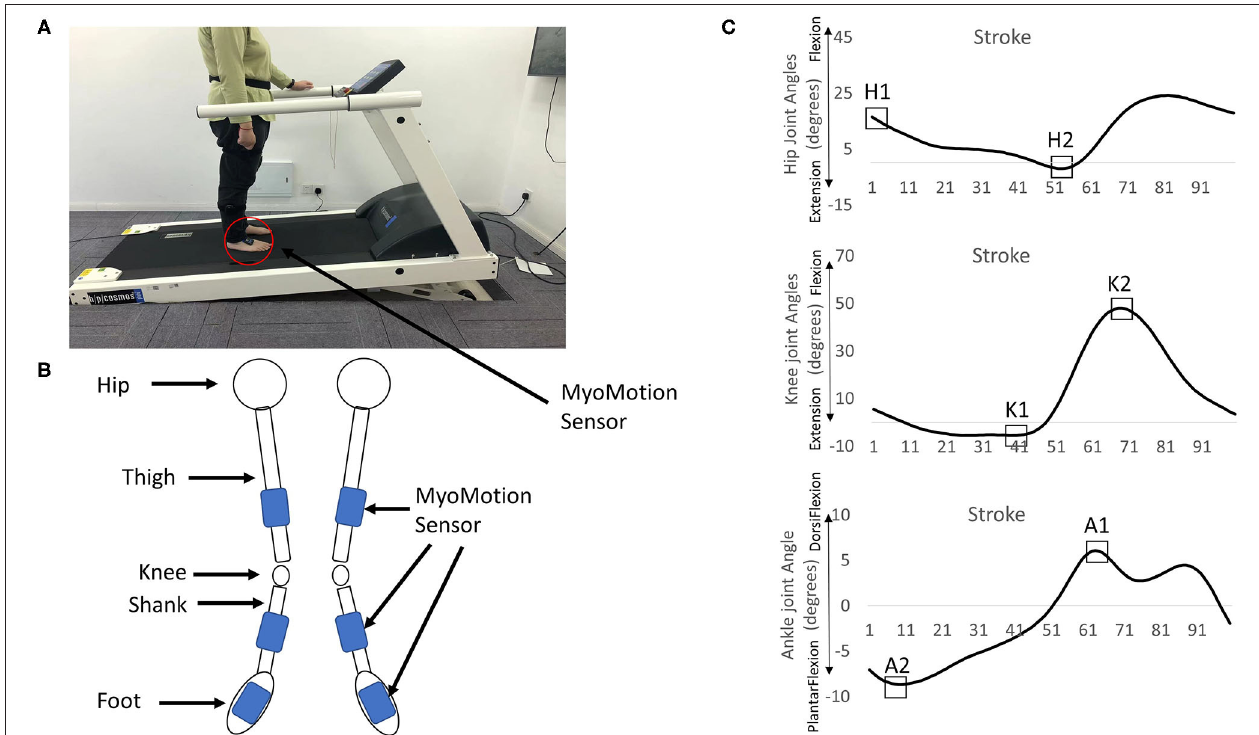
FIGURE 1 | (A) The treadmill and the myoMotion sensors. (B) Six myoMotion sensors were attached on the thigh (frontal and distal half of the femur), the shank (front and slightly medial of the tibia), and the foot (upper foot, slightly below the ankle) through elasticated straps. (C) The focus of interests: [1] The peak of the hip flexion angle at the heel strike (H1), [2] the peak of the hip extension angle (H2), [3] the peak of the knee extension angle (K1), [4] the peak of the knee flexion (K2), [5] the peak of the dorsi-flexion angle (A1), and [6] the peak of the plantar flexion angle (A2) in the non-paretic/dominant leg and the paretic/non-dominant